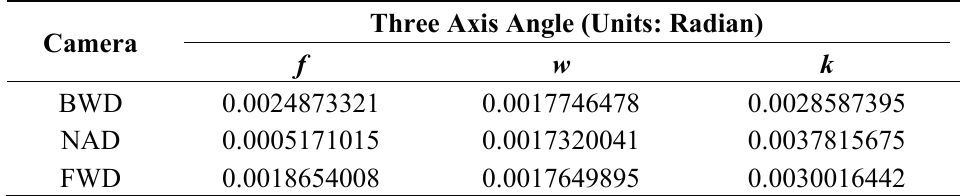
Table 2. Exterior orientation result (three panchromatic cameras).